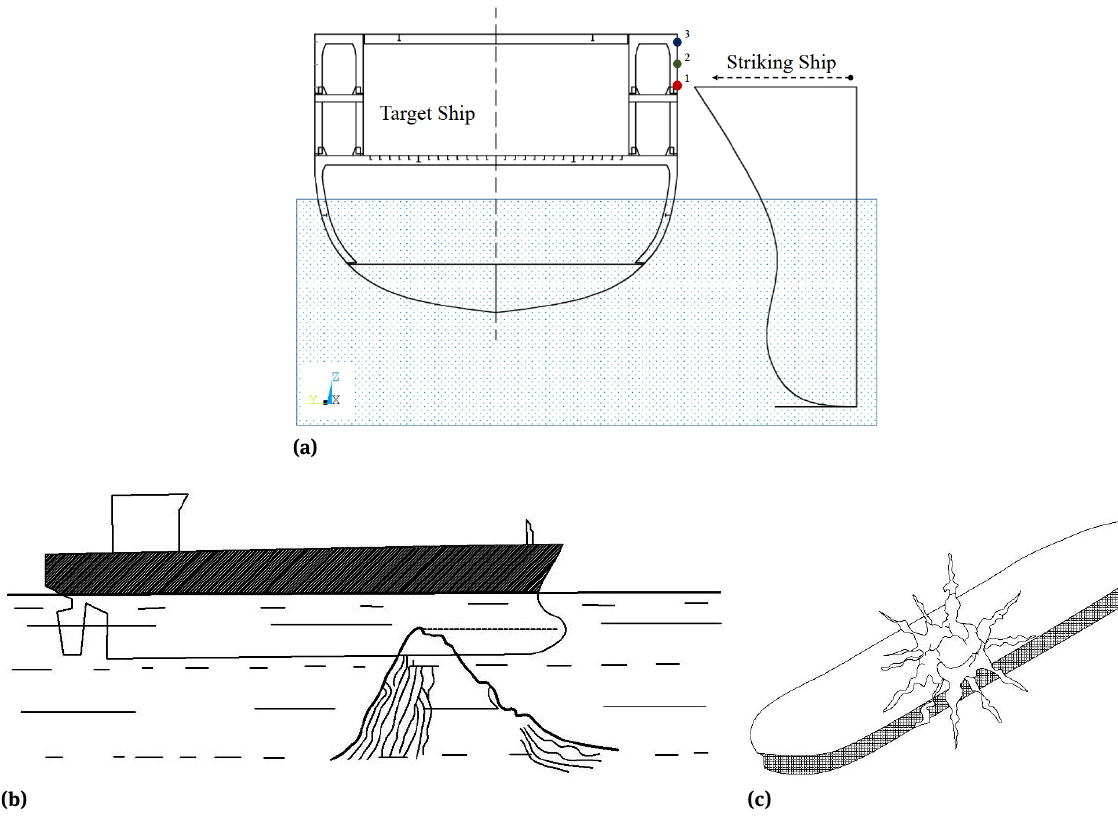
Figure 2: Impact loading in maritime environment: (a) collision, (b) grounding and (c) explosion